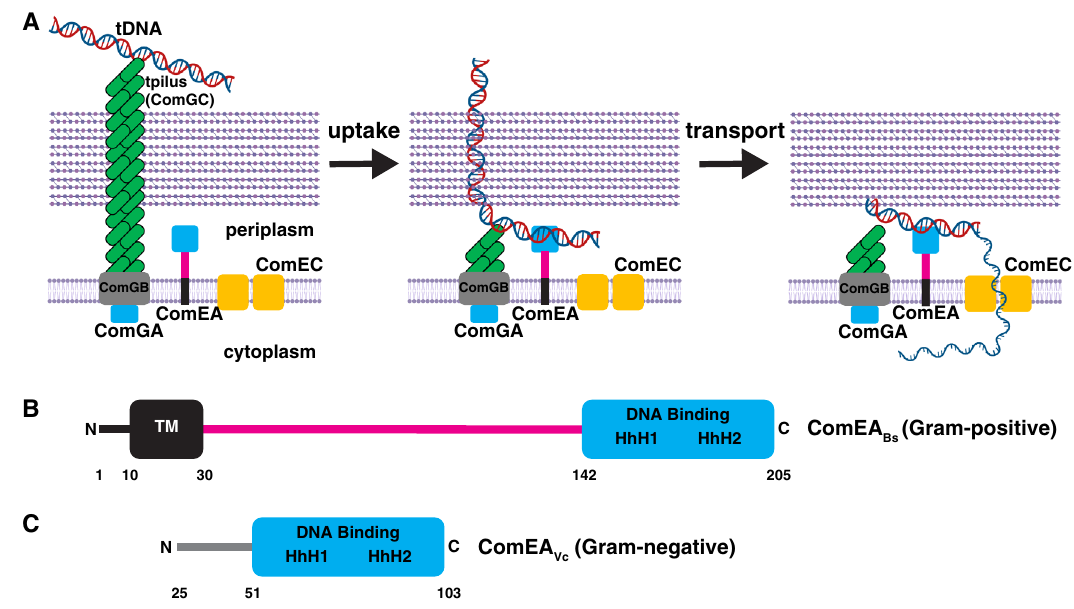
Fig.1|ExistingmodelofgenetictransformationinGram-positivebacteria,and ComEA domain architecture in Gram-positive and Gram-negative bacteria. A ThetpilusiscomposedofComGC,whoseassemblyrequirestheATPaseComGA. The tpilus isbelieved to be anchored to the membrane protein ComGB.The tpilus binds weakly to DNA and retracts to pull it into the periplasm. Here, the DNA encounters ComEA, which stabilizes binding to the cell and propels continued uptake ofthe DNA.ComECis proposed to degradeone strand ofDNAand provide the channel for transport of DNA into the cytoplasm. B Domain architecture of